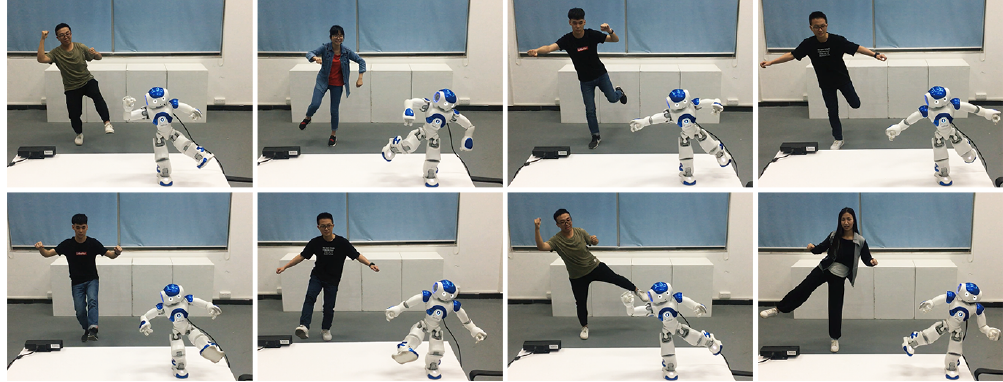
Figure 16. Snapshots of some difficult single-support motions that the robot can perform by imitating human demonstrators with different body